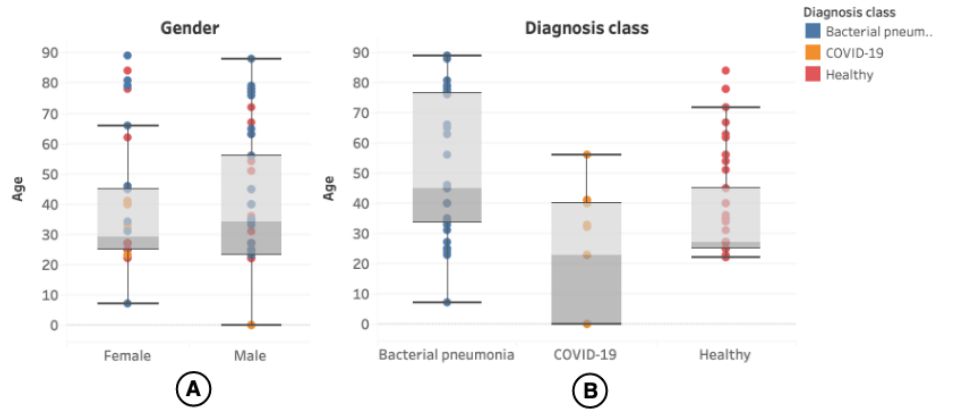
Figure 4. ( A ) shows the distribution of age in the LUS videos. ( B ) shows the distribution of age segmented by diagnosis class. Each colored dot on the image represents a patient undergoing the LUS exam and the different diagnosis classes to which the exam is